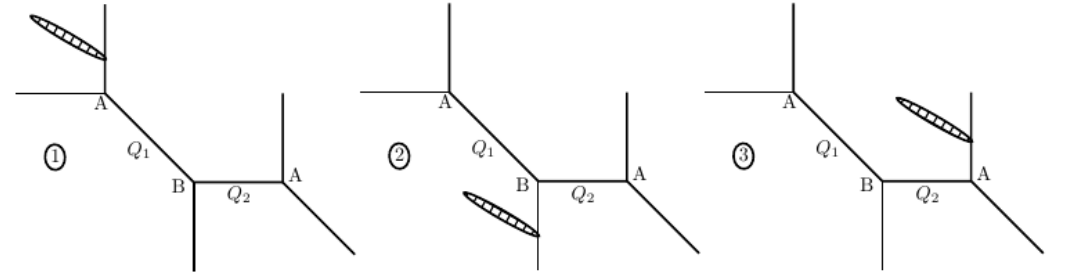
Figure 7: Toric diagram for a toric manifold with two Kähler